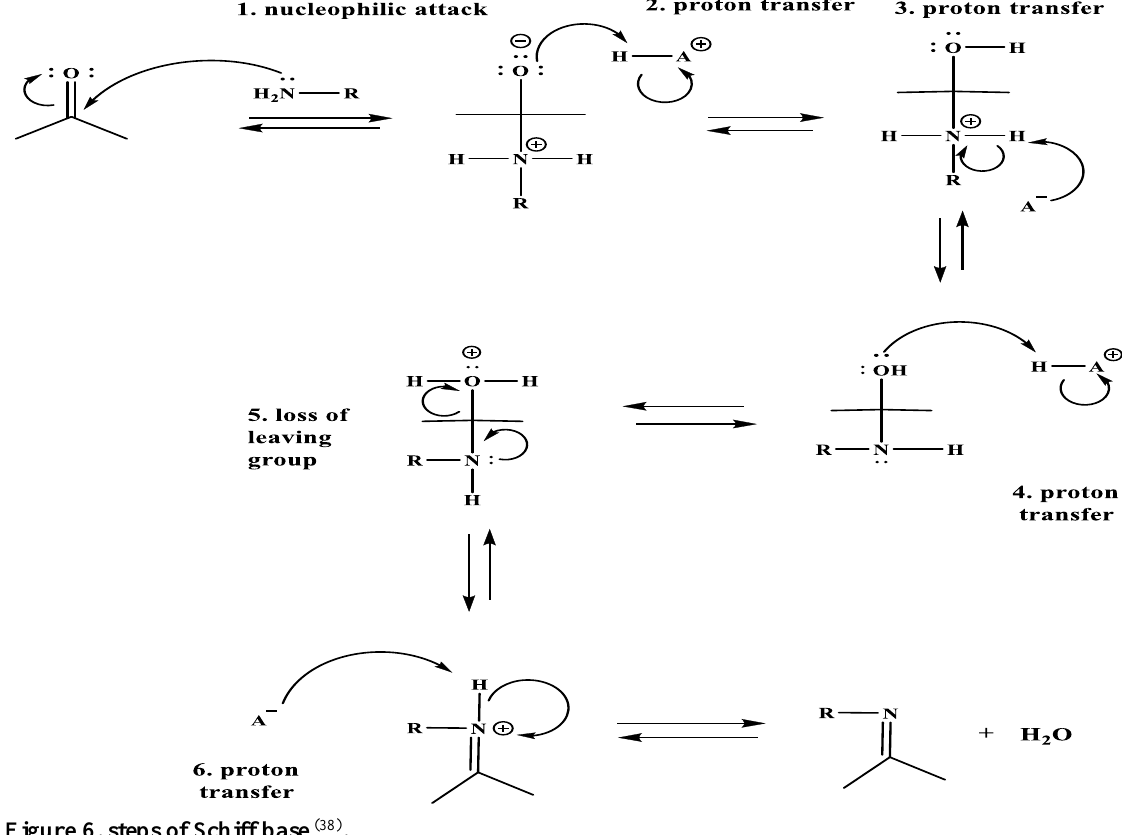
Figure 6. steps of Schiff base (38)